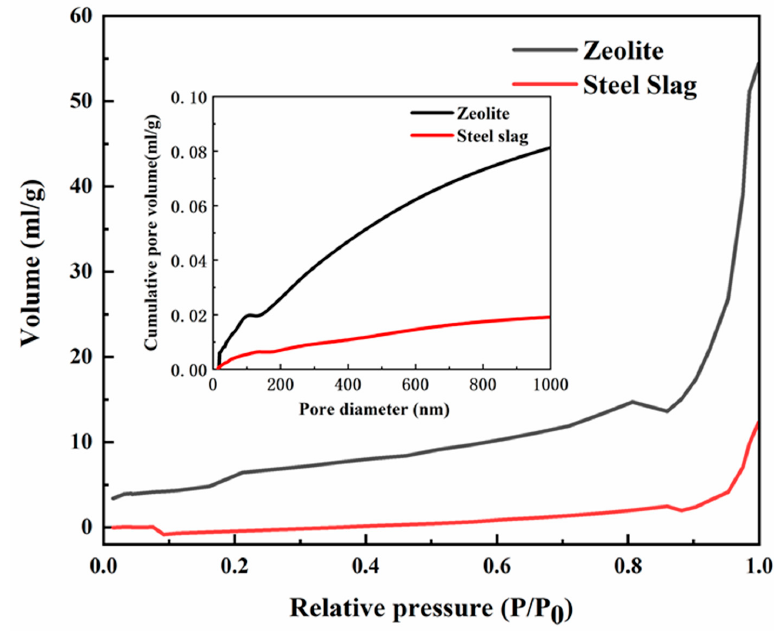
Figure 1. Nitrogen adsorption–desorption isotherms on steel slag and zeolite. Materials 2020 , 13 , x FOR PEER REVIEW